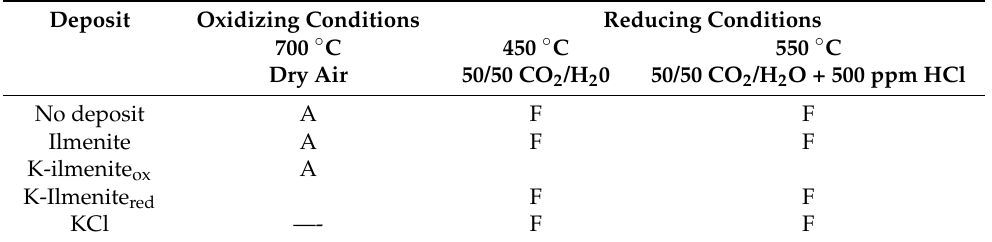
Table 1. Summary of test conditions. A—metals tested for air reactor; F for fuel